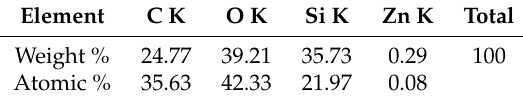
Table 1. EDS details of ZnPc.